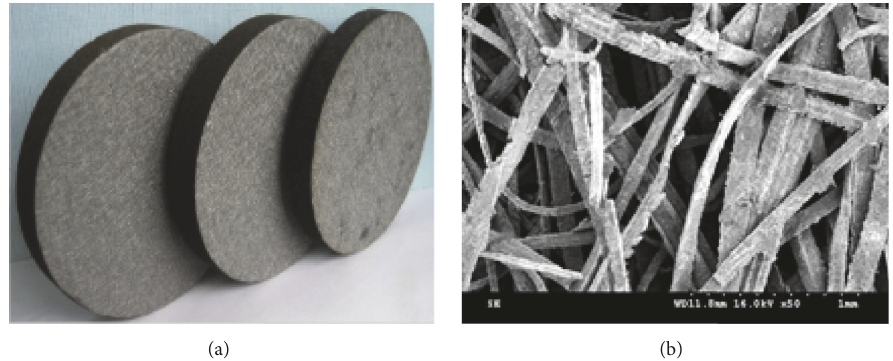
Figure 1: The PFMM samples: (a) photograph of the samples; (b) SEM photo of micrographic